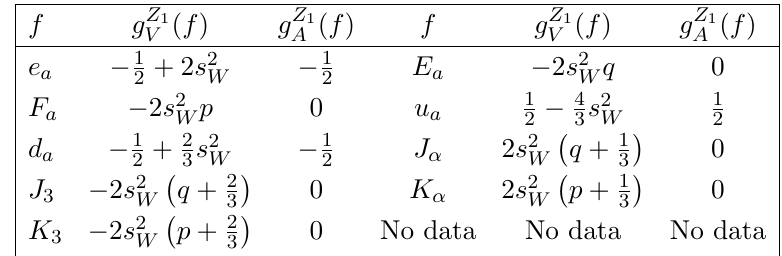
1 with fermions.